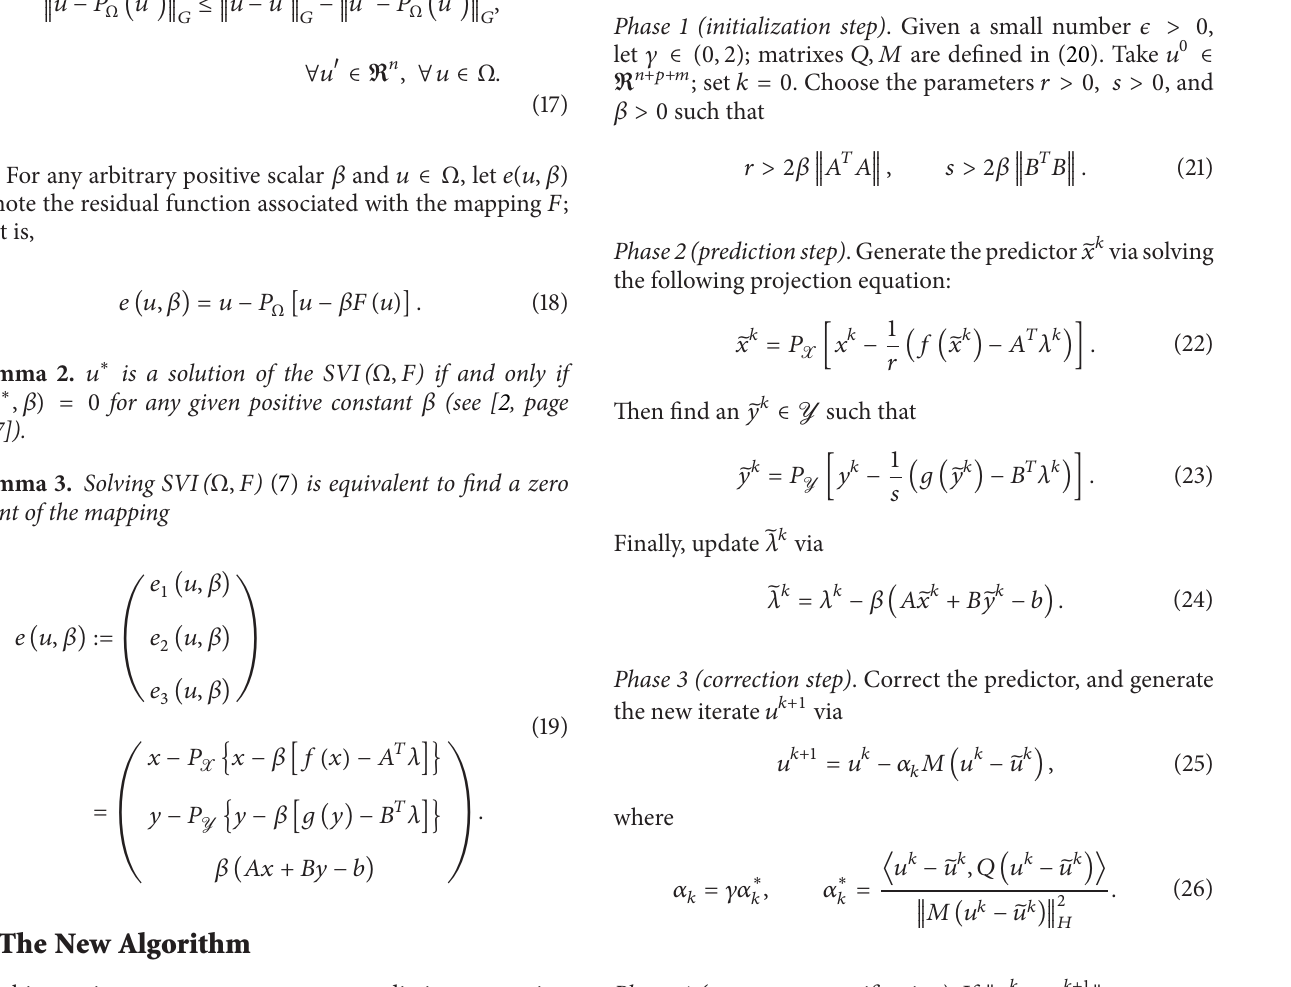
Algorithm 4. It is a prediction-correction-based